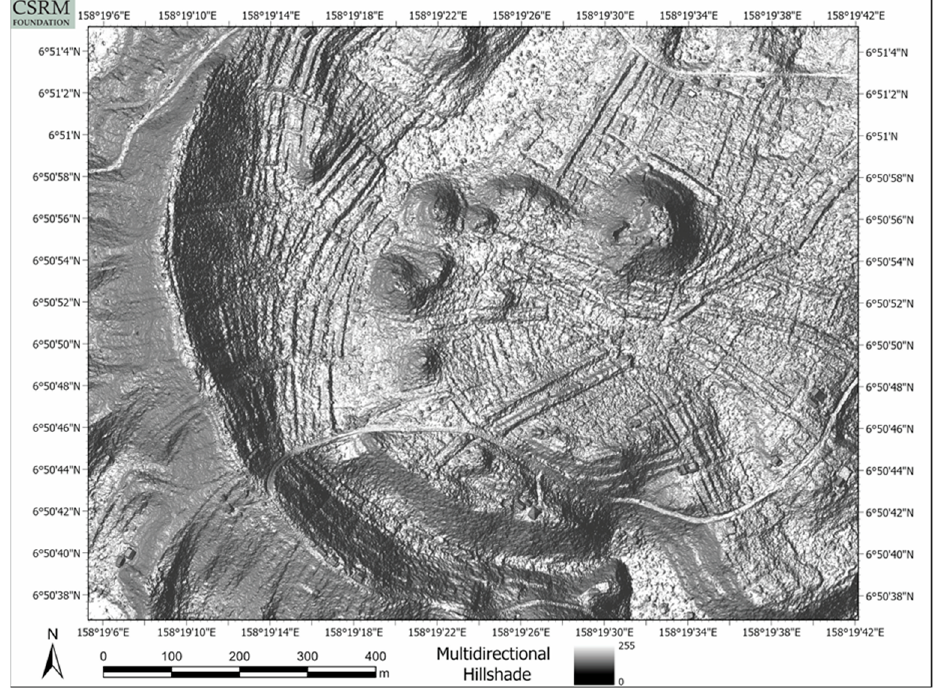
Figure 11. A multidirectional hillshade of the central area of Temwen Island, revealing its complex cultivation system.